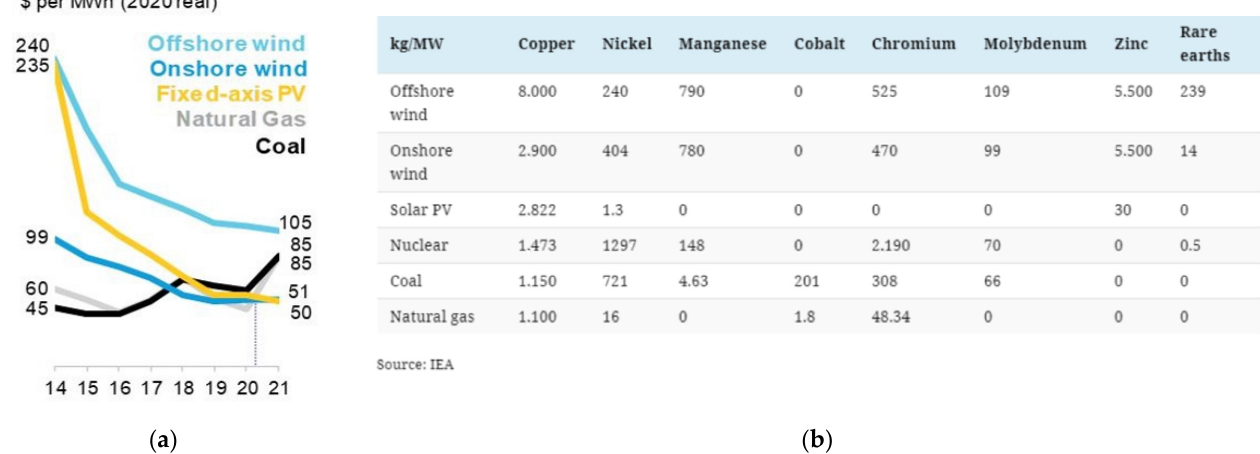
Figure 2. ( a ) LCOE for new solar and wind versus the running cost of existing coal- and gas-fired power plants in Germany, 2014–2021 (BloombergNEF); ( b ) minerals used in clean energy technologies compared to other power generation sources (IEA, 2021).